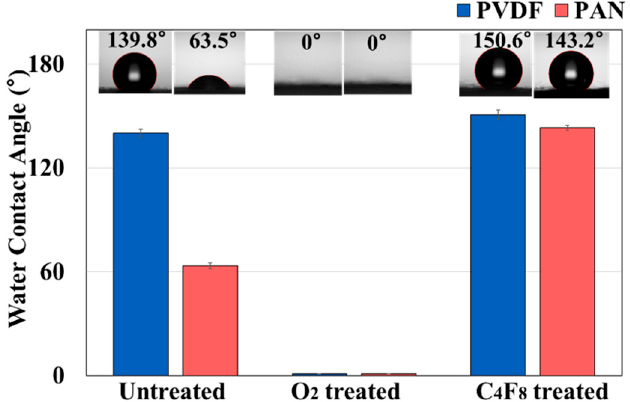
Figure 7. The water contact angle of the ML/PVDF and ML/PAN composites for different surface treatments including hydrophilic O 2 plasma and hydrophobic C 4 F 8 plasma processes.